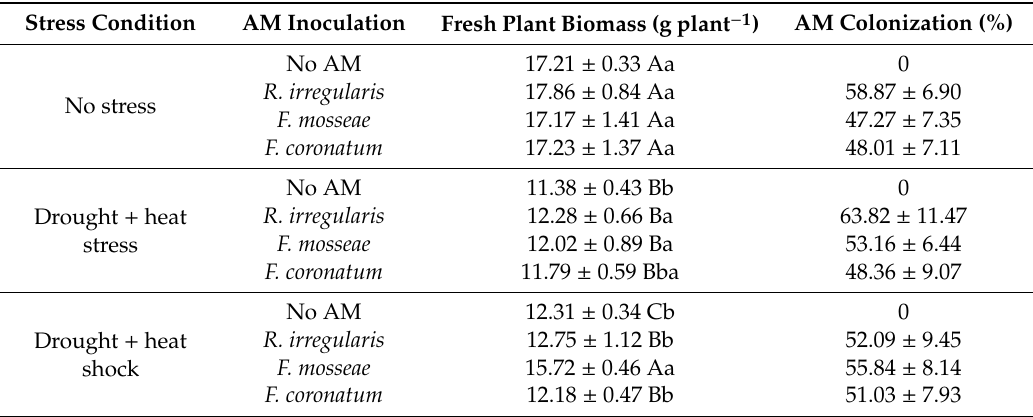
Table 2. Fresh plant biomass and AM colonization rate in plants not inoculated or inoculated by R. irregularis , F. mosseae , or F. coronatum under no stress, drought + heat stress, and drought + heat shock after eight weeks of